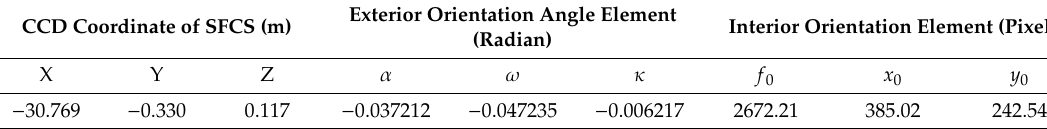
Table 2. The interior and exterior orientation elements of the CCD camera.